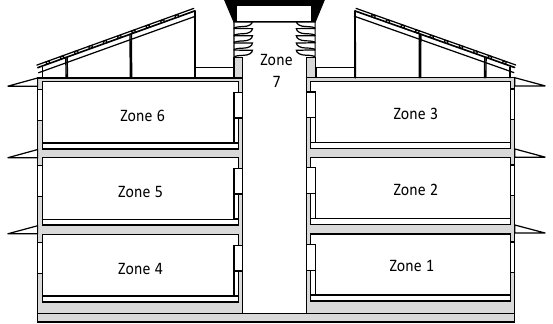
Figure 4. Building model for validation.